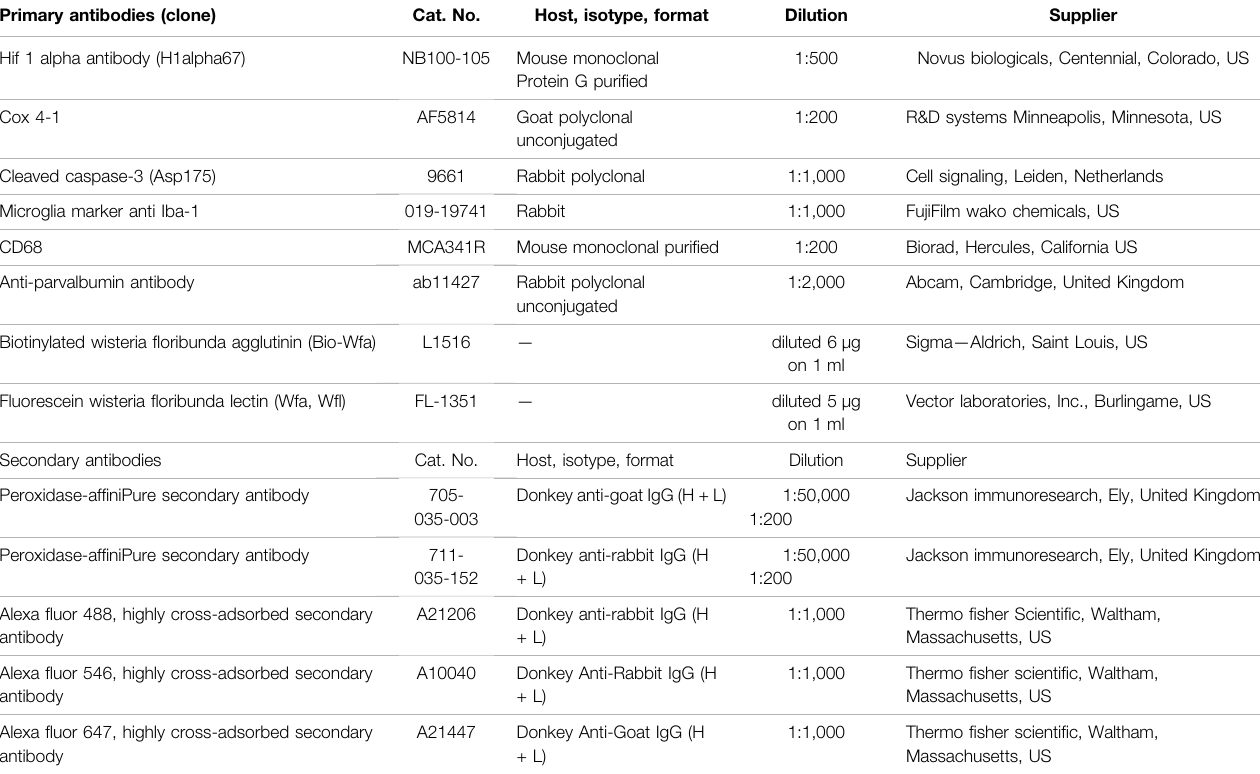
TABLE 1 | List of primary and secondary antibodies used in Western blot and immunohistochemistry. Primary antibodies (clone) Cat.